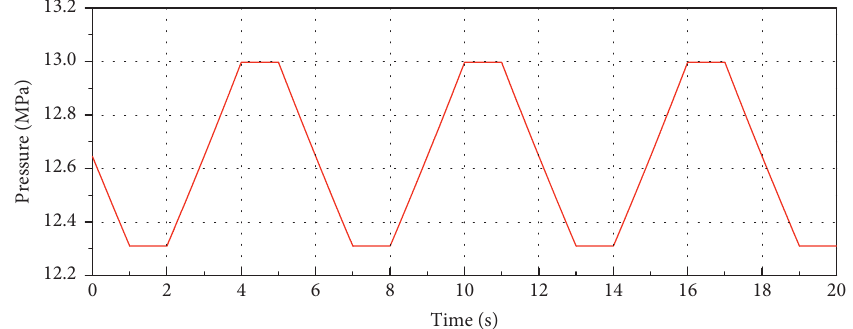
Figure 19: Pressure of the storage chamber in test 2.